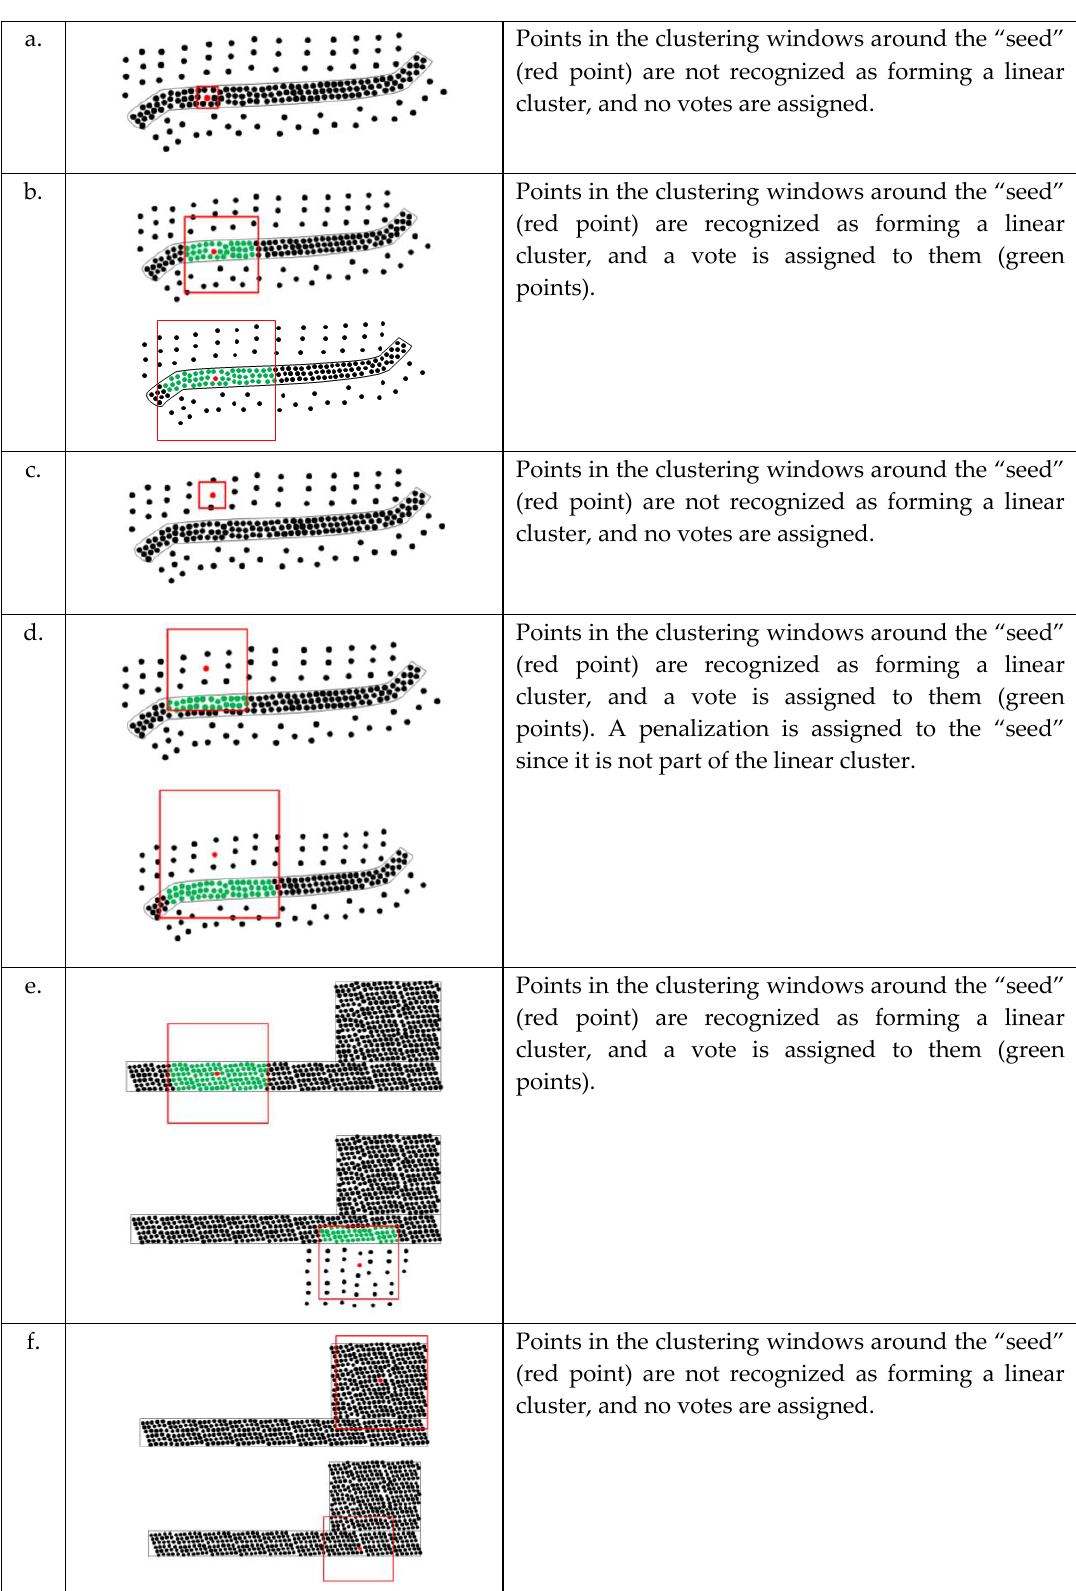
Figure 7. Some typical cases of voting: ( a , b ) votes at different scales for a road point, ( c , d ) votes for a bare ground point, and ( e , f ) votes for a point in parking lot areas.